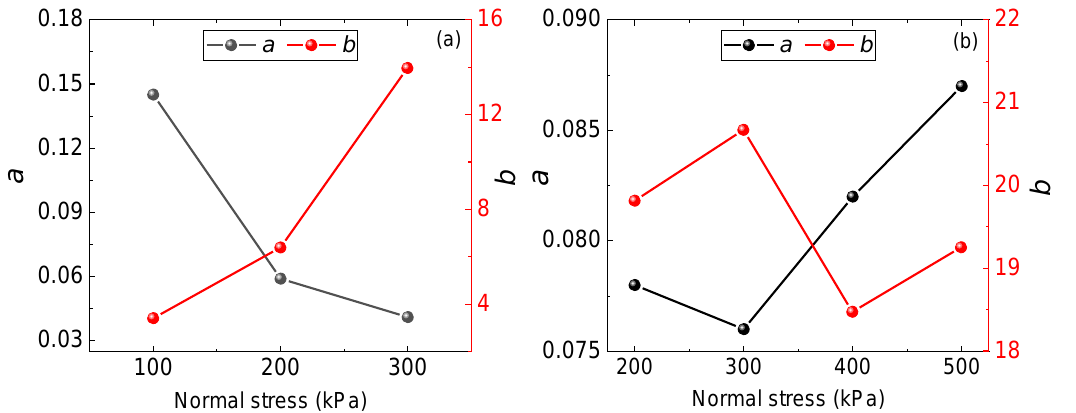
Figure 12. Parameters of the constitutive model based on Gamma distribution. ( a ) Gamma distribu- tion parameter of type A curves; ( b ) Gamma distribution parameter of type B curves.